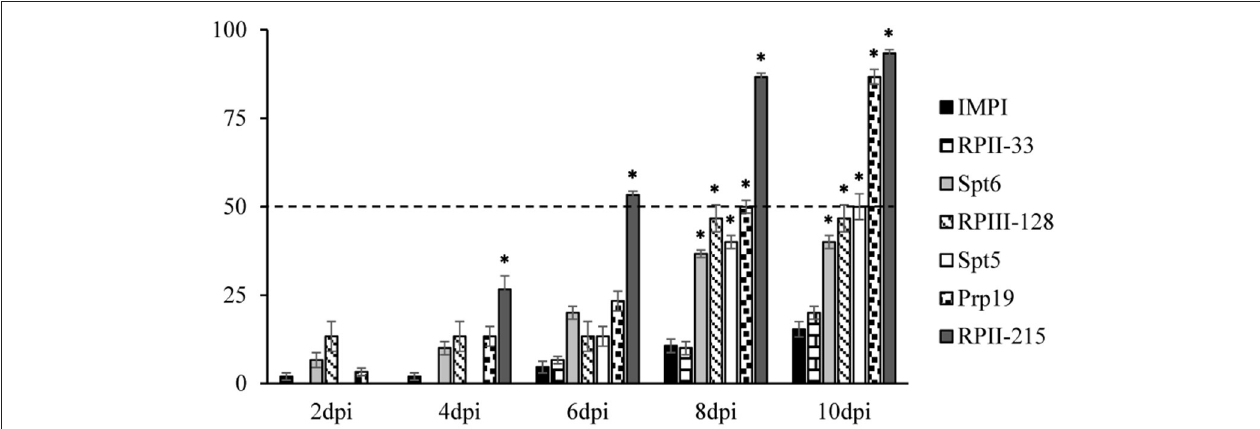
FIGURE 5 | Survival rates of B. aeneus after knockdown of genes involved in the process of transcription. Injection of 150 nl of gene-specific dsRNA [250 ng/ µ l] was injected into B. aeneus adults. Mortality rates were tracked every 48h for 10 days (dpi = days post injection). The G. mellonella gene IMPI was used as negative control. The data represent three biological replicates ( n = 10 for each replicate). Asterisks show statistical difference ( p < 0.001). The results were analyzed with analysis of variance (ANOVA) ( Supplementary Table 1